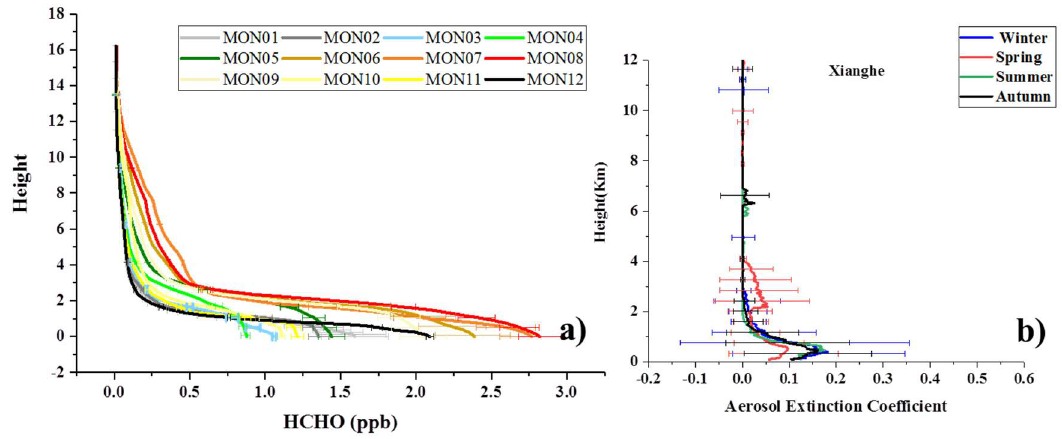
Figure 11. Monthly mean HCHO profile and seasonal mean AEC in Xianghe.